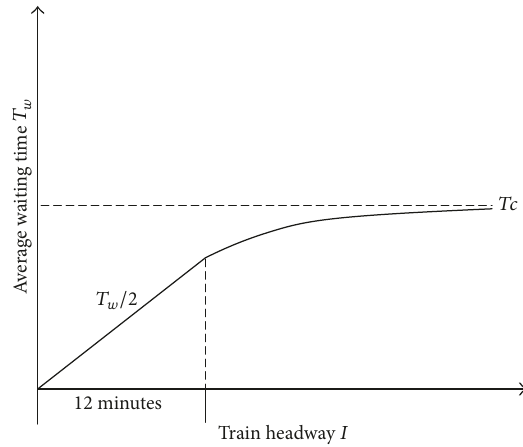
Figure 2: Relationships between the average waiting time and the